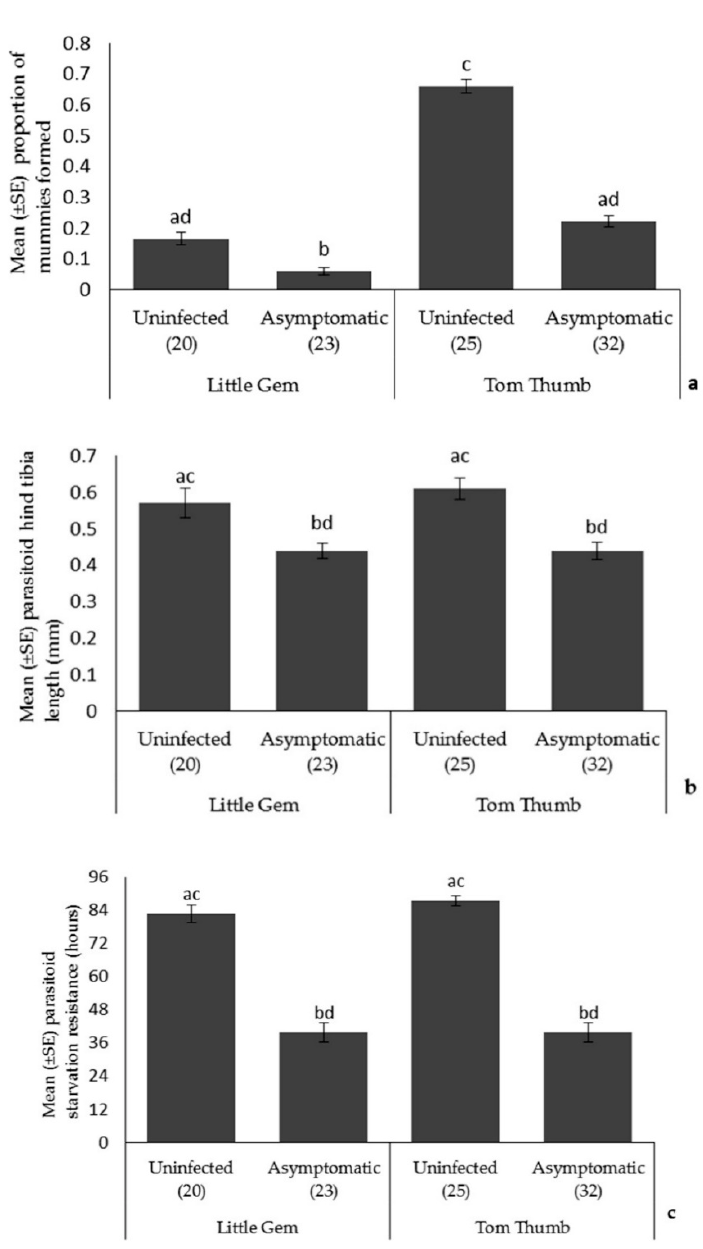
Figure 2. The effect of asymptomatic B. cinerea infection status and plant variety on Mean ± SE ( a ) proportion of parasitoid mummies formed; ( b ) parasitoid hind tibia length; and ( c ) parasitoid starvation resistance. Number of plant replicates per treatment is shown below each bar; treatments sharing the same letters above each bar are not significantly different at p < 0.05 following post-hoc tests.